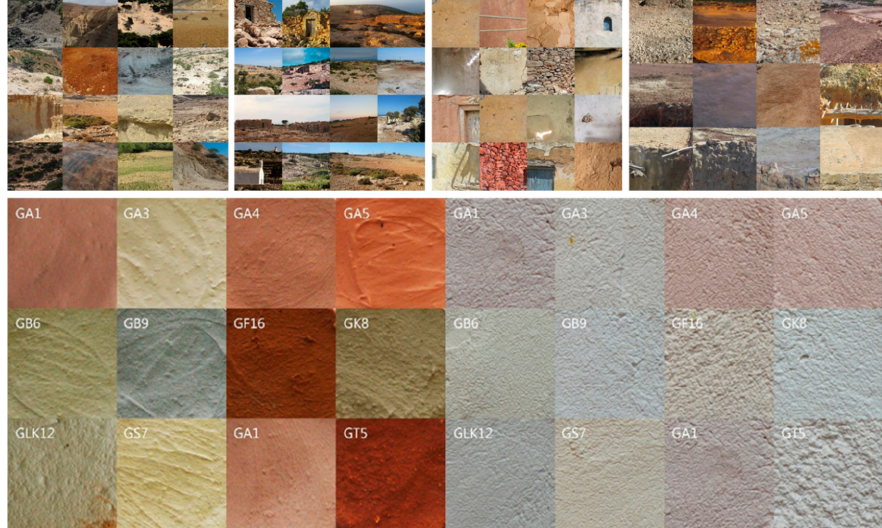
Figure 14. Study on the existing colour palette of the island and the colour palette developed from earth-based and lime-based mortars.